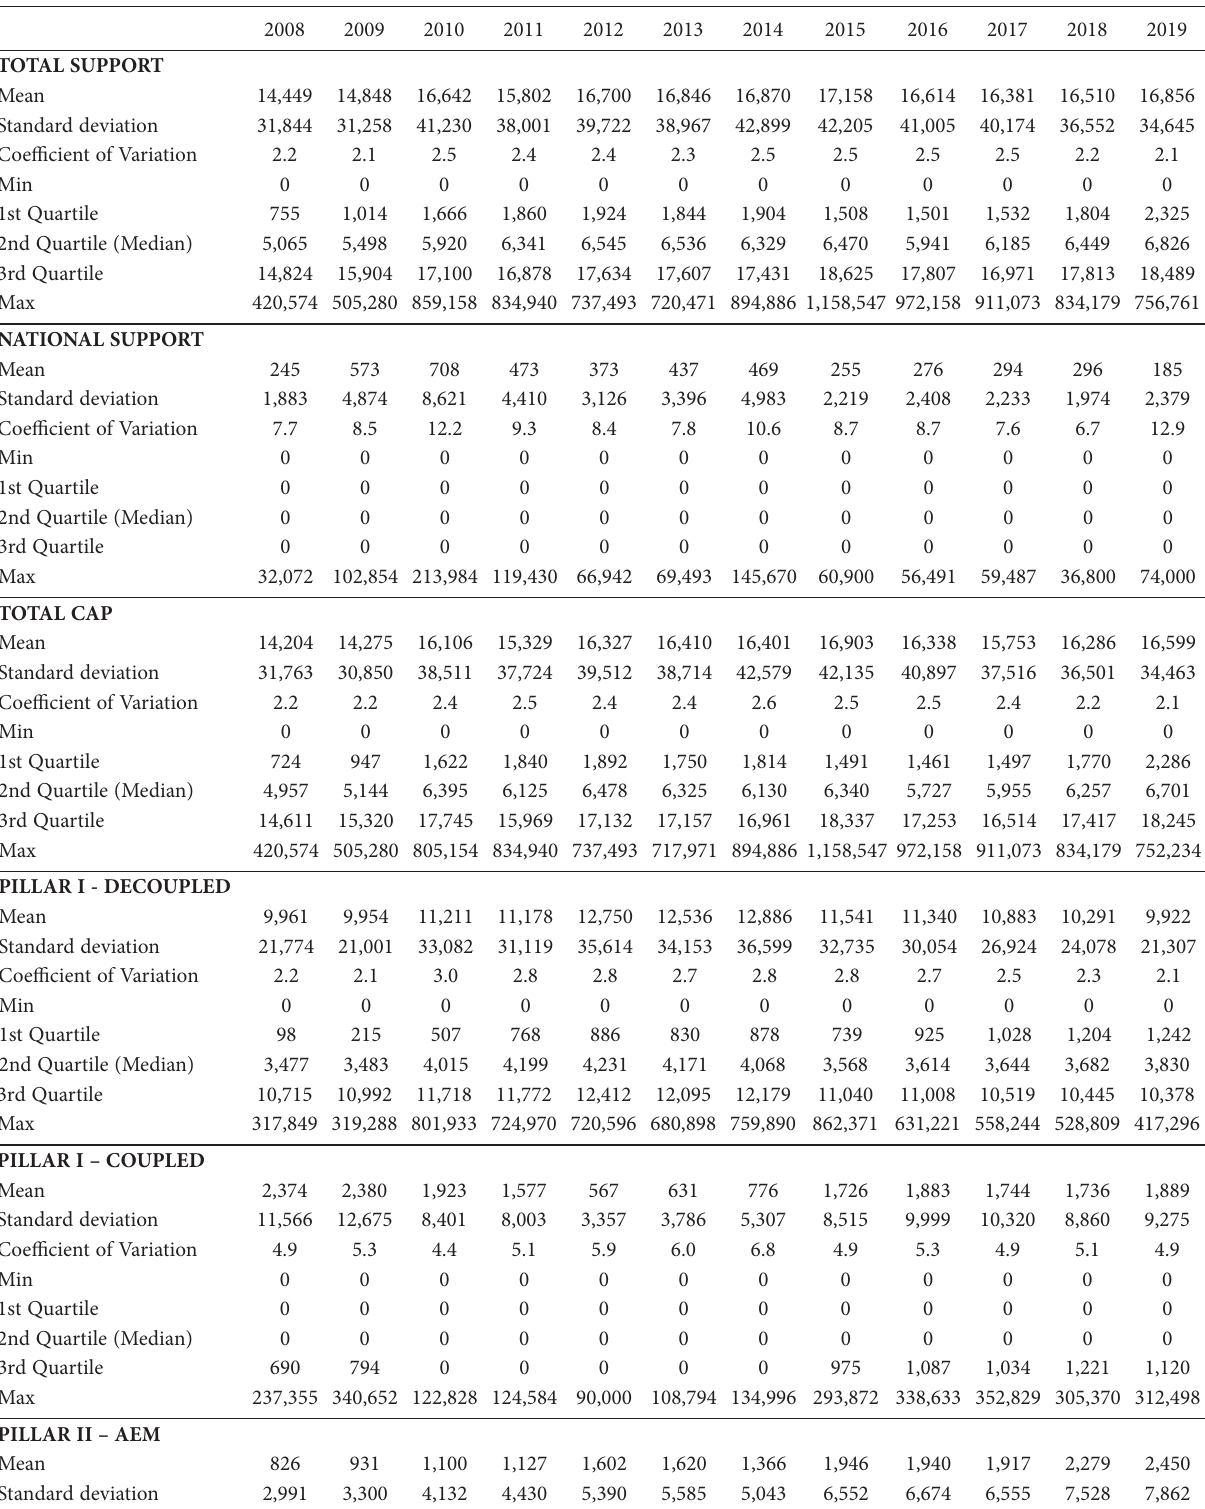
Table 1. Distribution of the public support (CAP included) within the Italian 2008-2019 FADN balanced sample